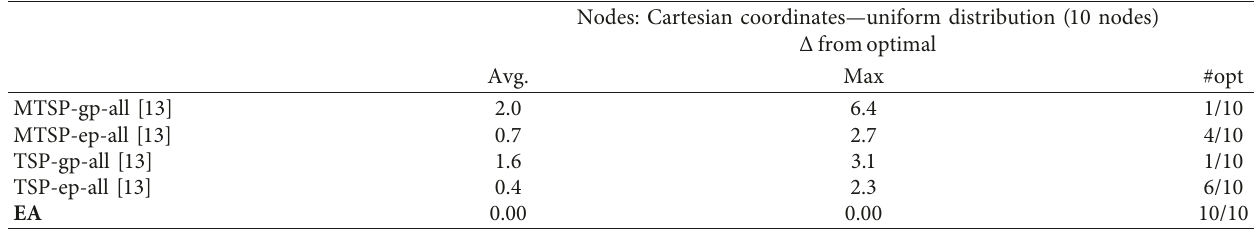
Table 1: Comparison against best-in-class heuristics. Comparison against “best-in-class” heuristic solutions to the optimal solution (uniform n � 10 nodes, α � 2, averaged over 10 instances).